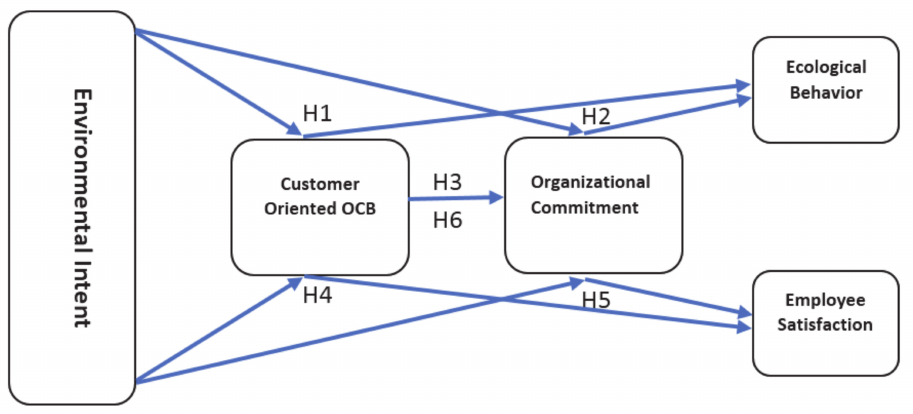
Figure 1. Research Framework.